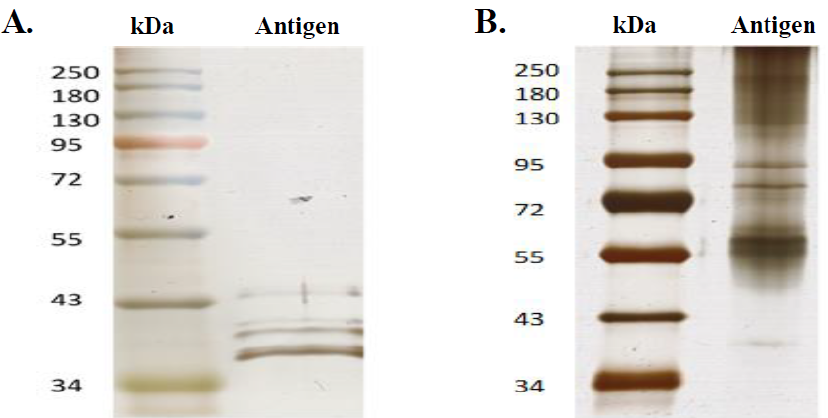
Figure 6. Silver stain SDS-PAGE analyses for poliovirus vaccine ( A ) and antigen of Ibou002 virus strain ( B ) proteins. In both profiles, the left lane corresponds to the standard molecular weight and the right lane to the antigen; 50 µg of poliovirus vaccine and 50 µg of antigen of Ibou002 virus strain were run in a 12% polyacrylamide gel.